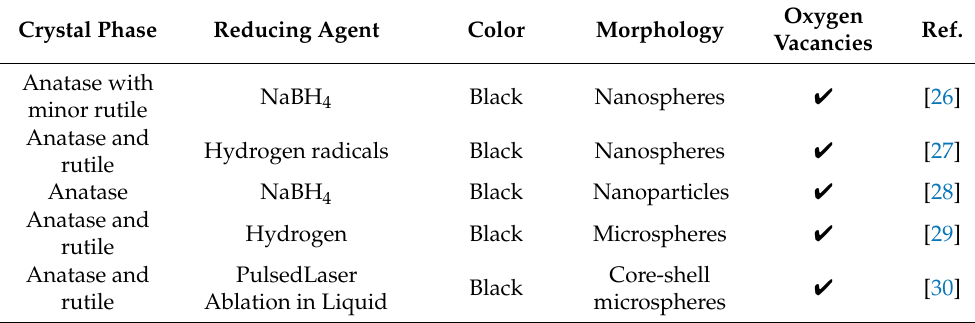
Table 1. Properties of black TiO 2